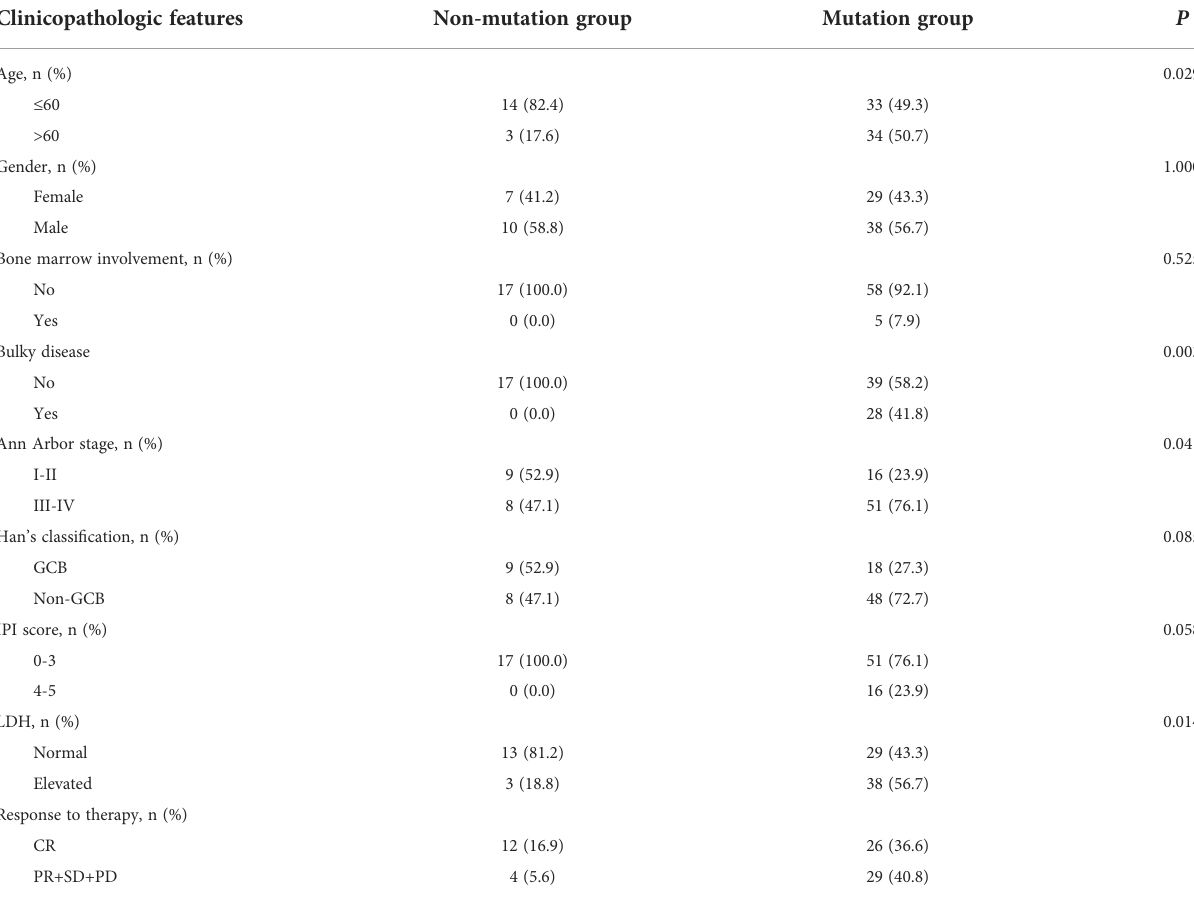
TABLE 2 The clinicopathologic features of DLBCL patients with mutation or without in validation group. Clinicopathologic